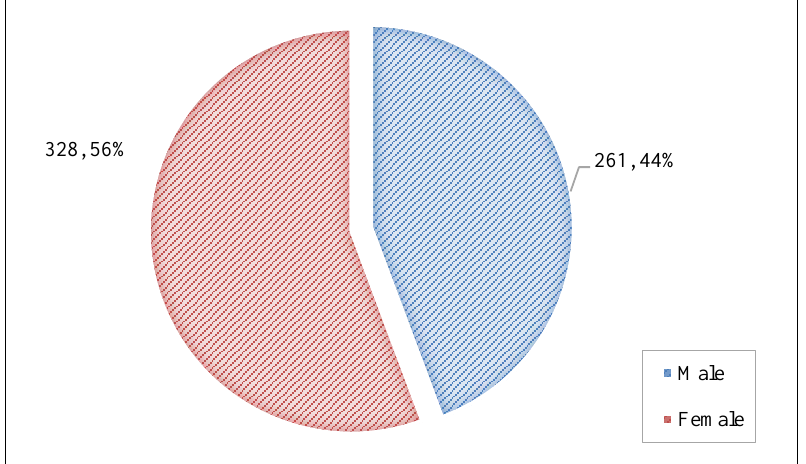
Figure 3. Statistical results for